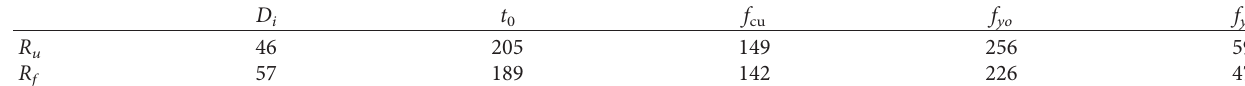
Table 5: The calculation results of range.